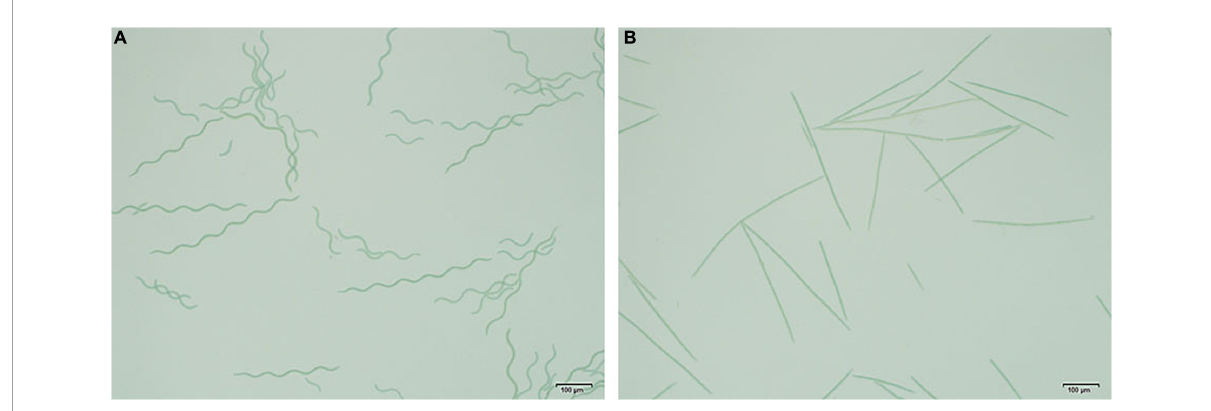
FIGURE1 Morphological photograph of Arthrospira platensis. (A) Morphological photograph of A. platensis OUC623. (B) Morphological photograph of A. platensis